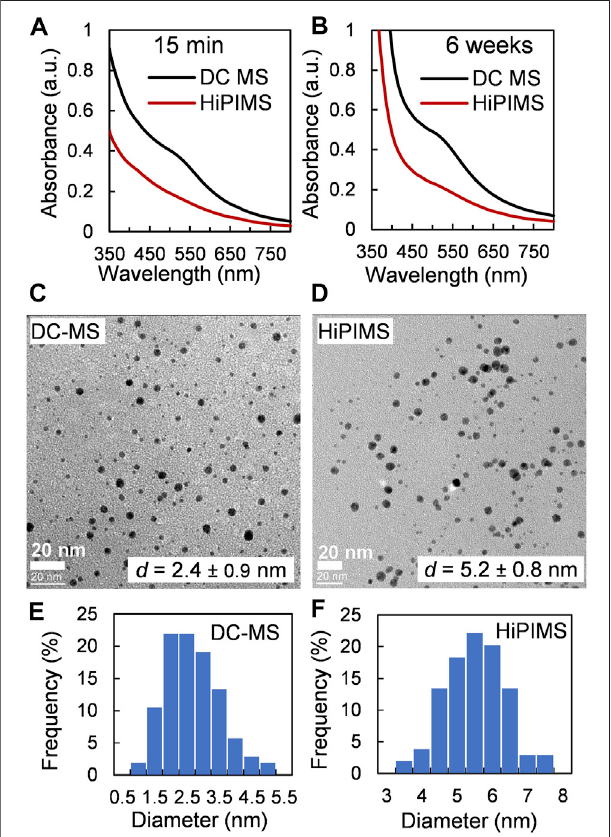
FIGURE 5 | Effect of plasma type: samples were obtained at a fi xed argon pressure of 0.7 Pa and a sputter time of 10 min. (A) and (B) UV-vis spectra of dispersions of Au NPs in castor oil recorded 15 min and 6 weeks after deposition, respectively. (C, D) TEM images and (E, F) size distributions of Au NPs obtained with DC-MS and HiPIMS power supplies,